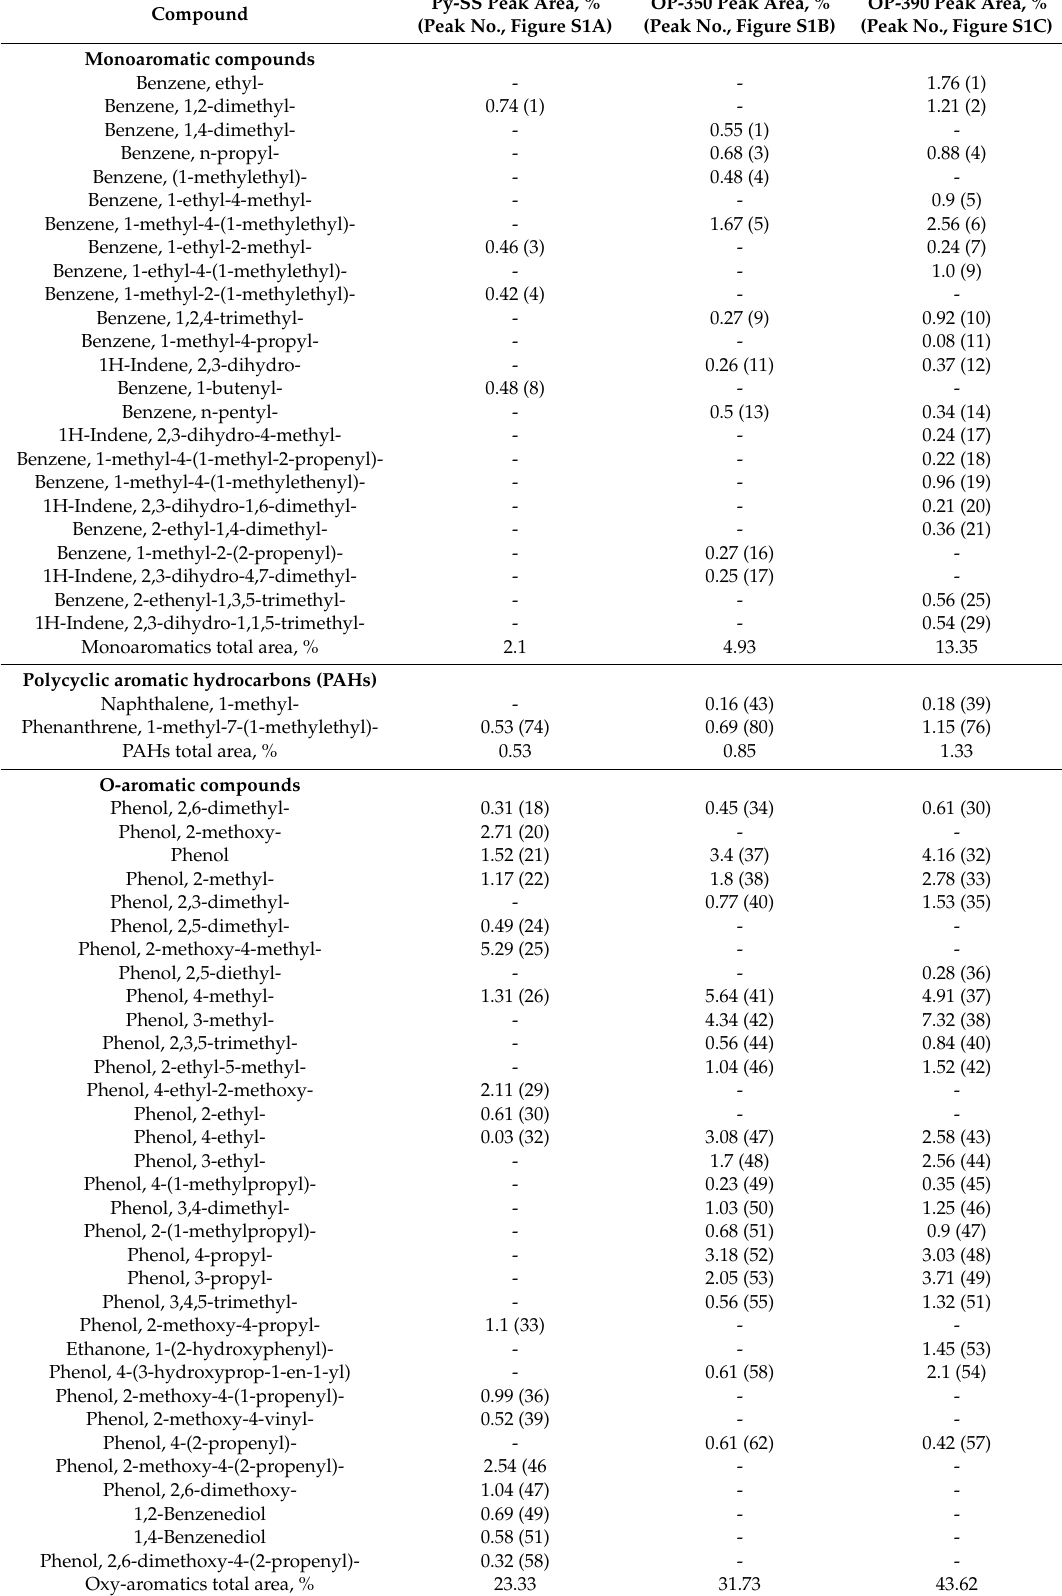
Py-SS Peak Area, % OP-350 Peak Area, % OP-390 Peak Area, % (Peak No., Figure S1A) (Peak No., Figure S1B) (Peak No., Figure S1C)